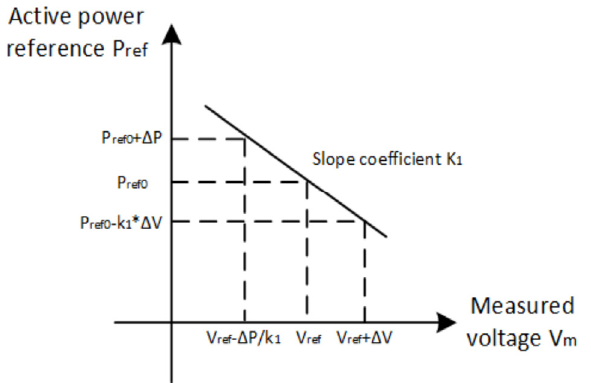
Figure 1. V-P control algorithm line chart.